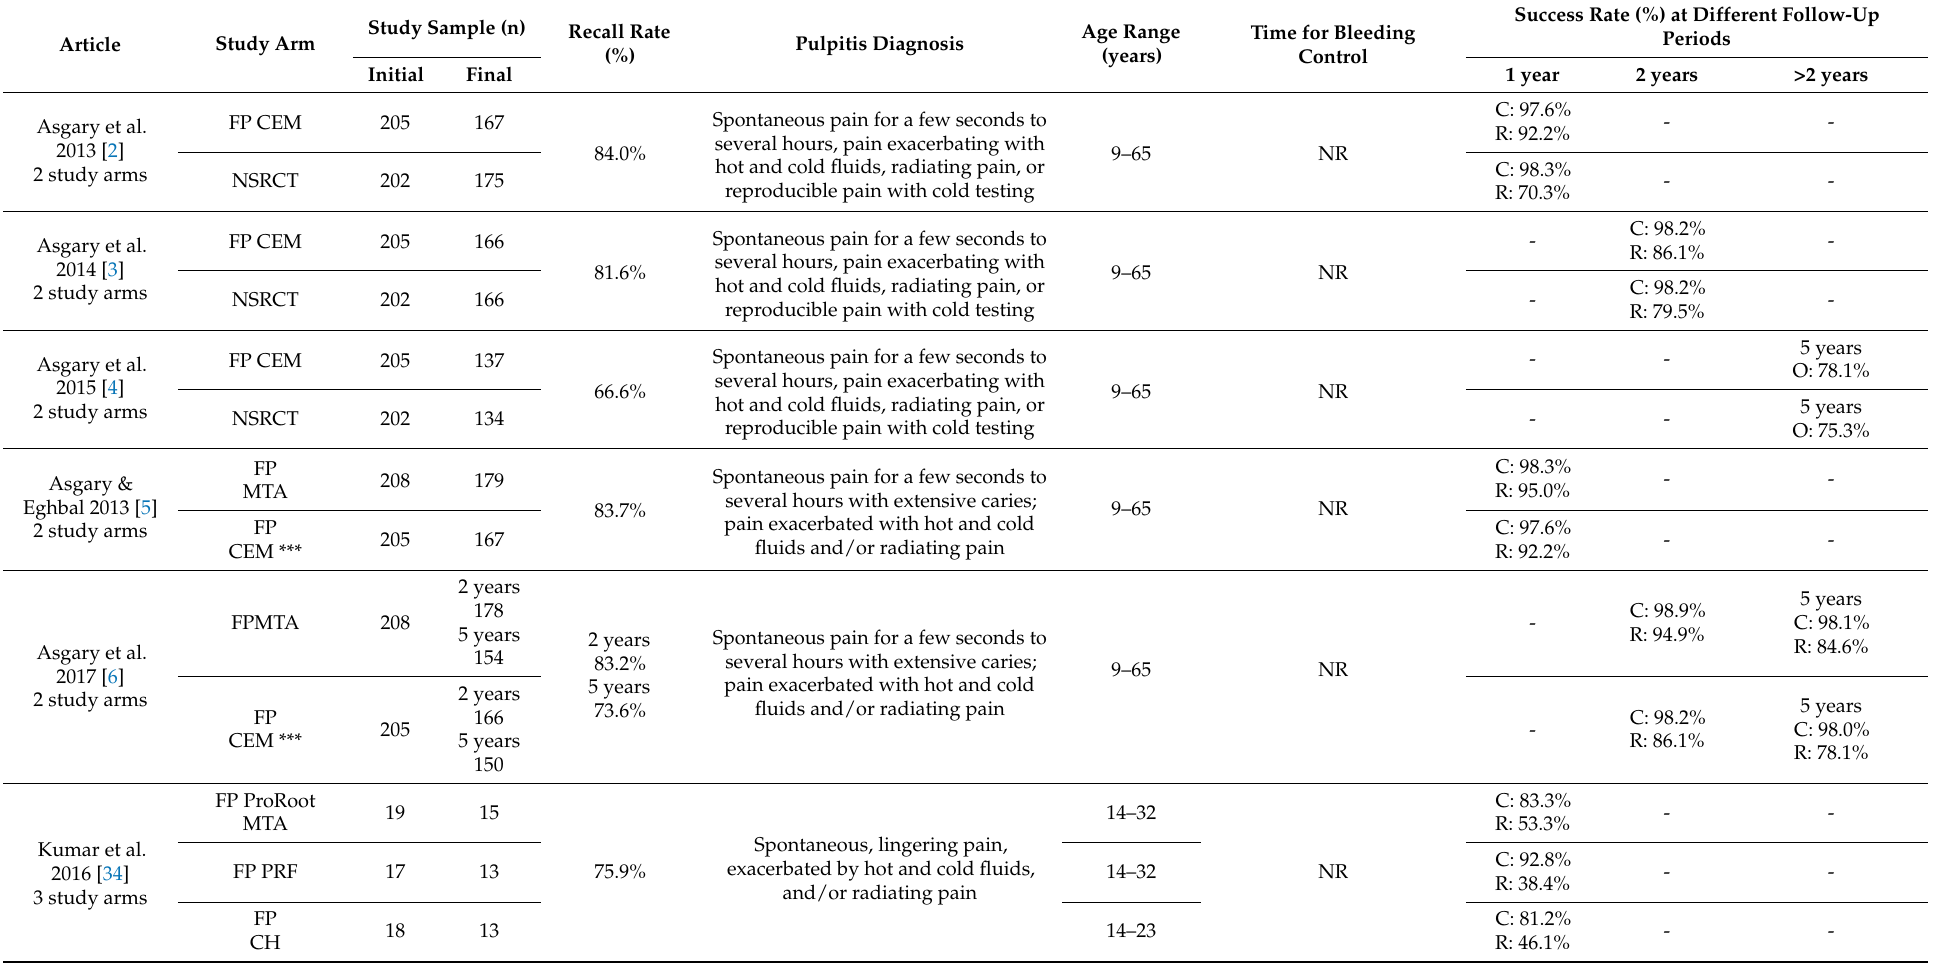
Table 3. Characteristics of included randomized controlled